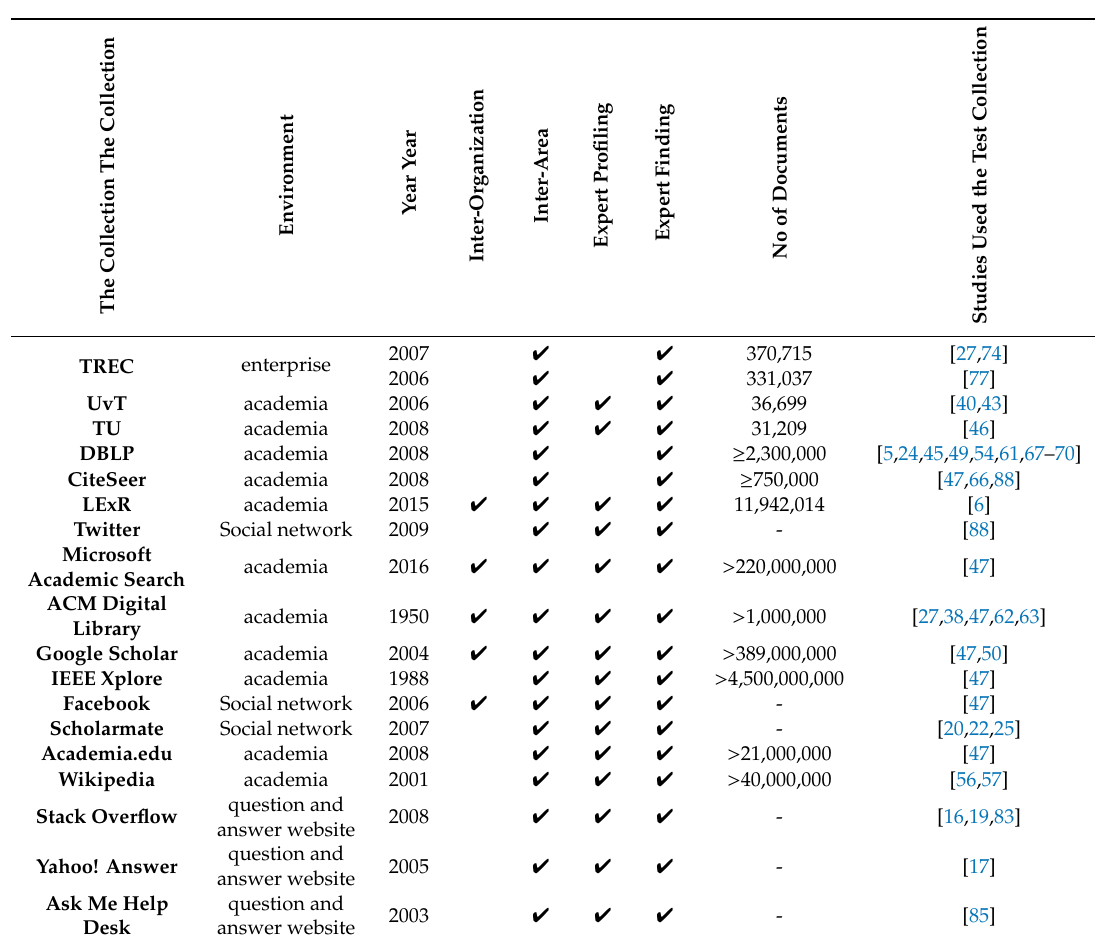
Table 9. Data set